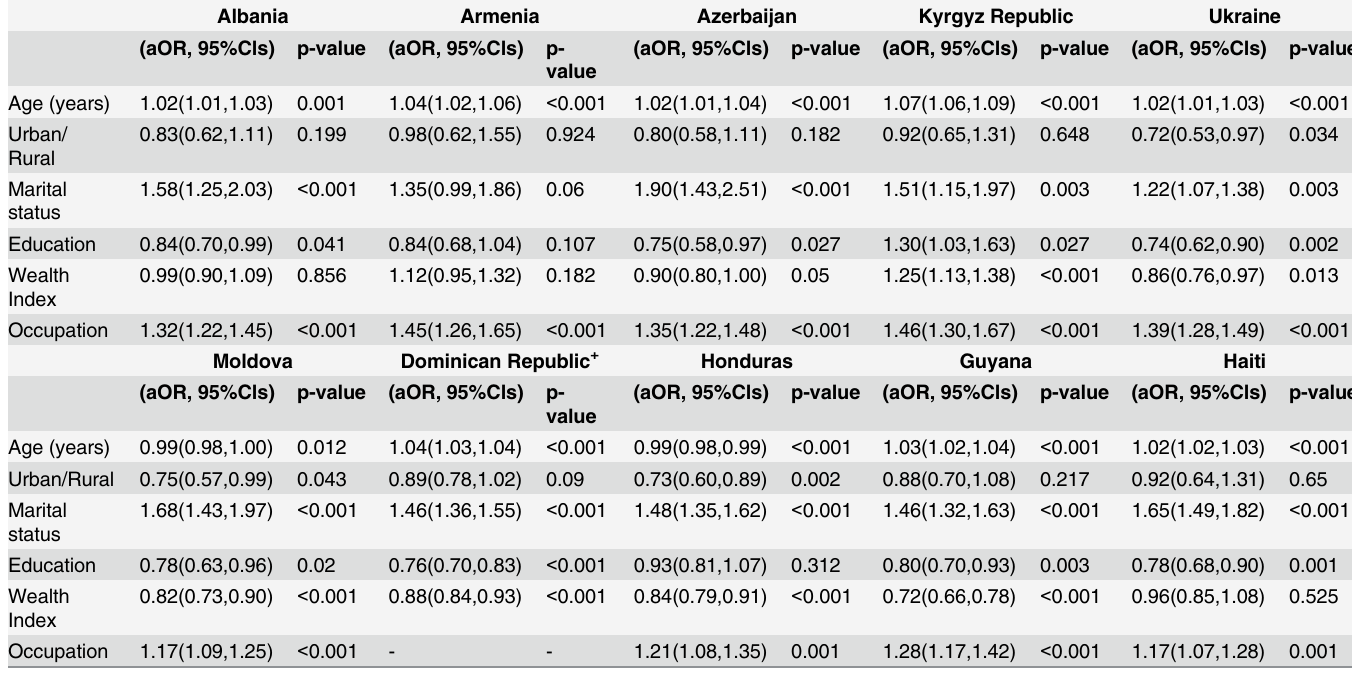
Table 6. Binary logistic regression analyses for demographic and socio-economic factors associated with smoking among men in 10 countries (Central Asia, Latin America and